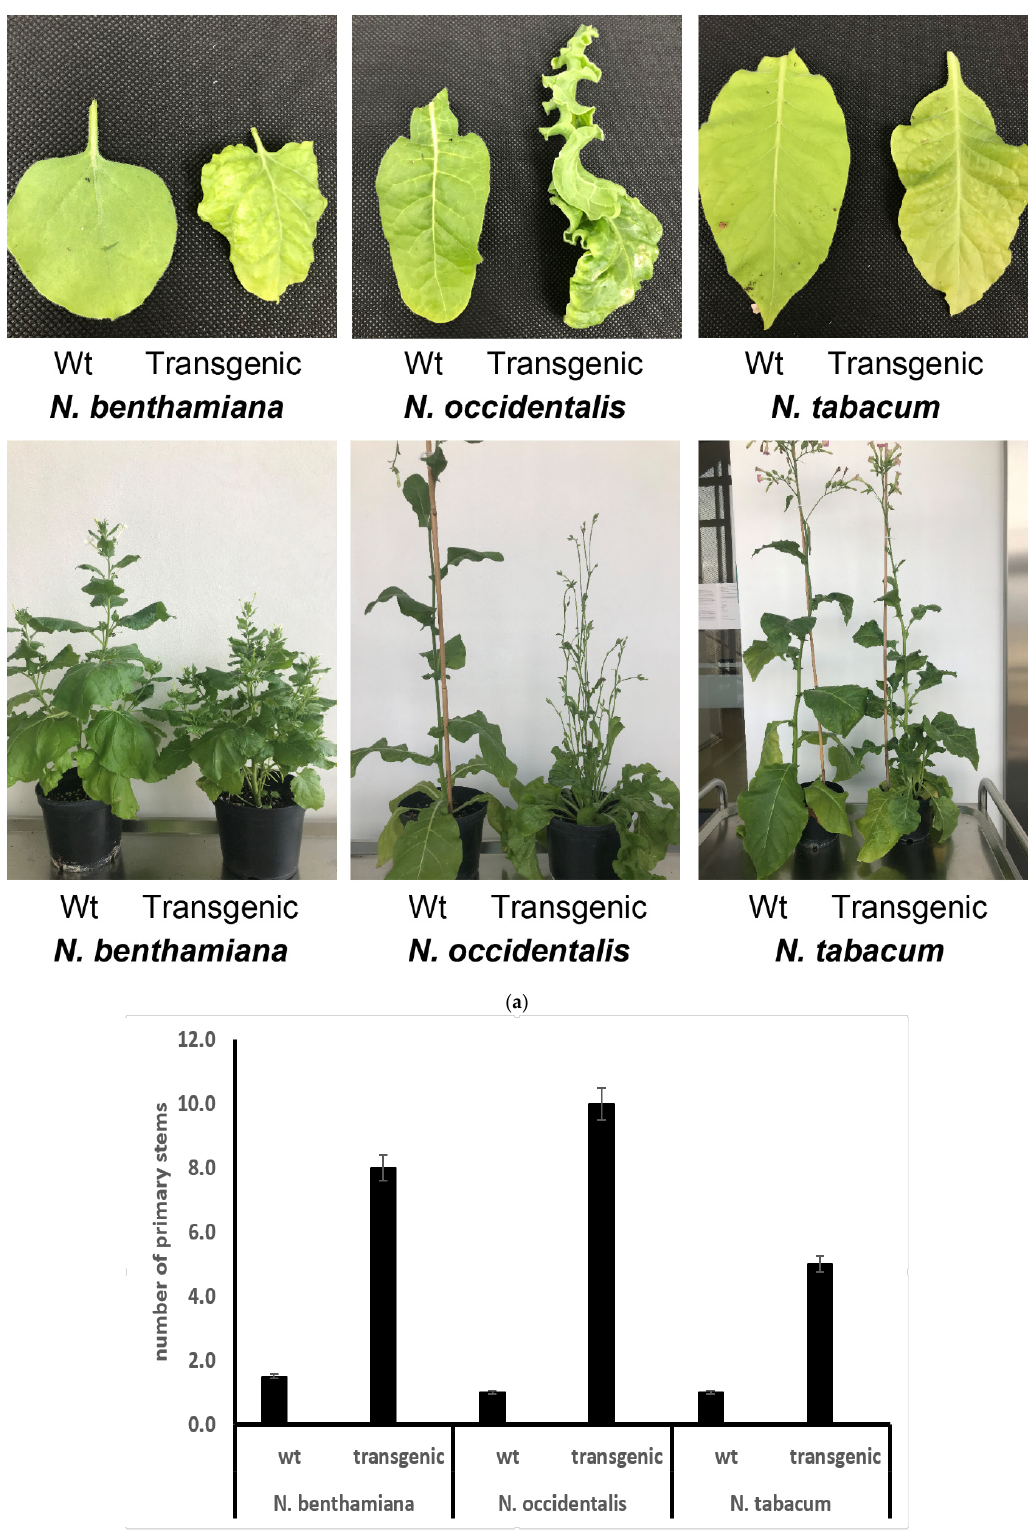
Figure 7. Transgenic tobacco plants expressing SAP11 PM19 . ( a ) Three different species of tobacco plant were used to establish transgenic plant lines expressing SAP11 PM19 under the control of the Cauliflower mosaic virus 35S promoter. The phenotypes of three transgenic tobacco plant species were compared with wt. ( b ) Number of primary stems developed by 3 transgenic tobacco species compared to their corresponding